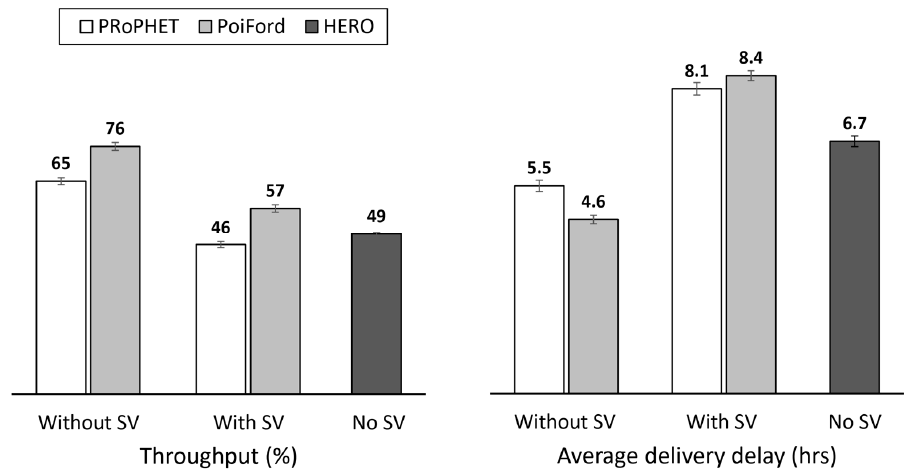
Figure 10. Throughput and average delivery delay of PRoPHET, PoiFord and HERO.